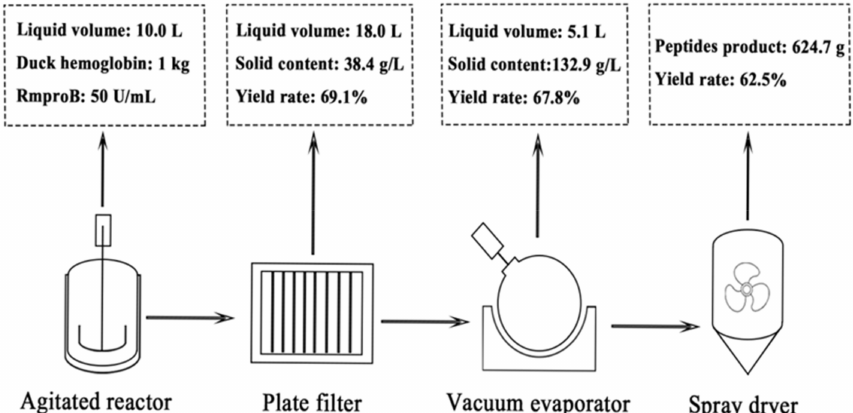
Figure 5. Flow diagram of production of duck hemoglobin peptides at kilo-scale. The solid content was defined as the ratio of the weight of the lyophilized solid to the total solution volume. The yield was defined as the percentage of the weight of the obtained duck hemoglobin peptides to the initial